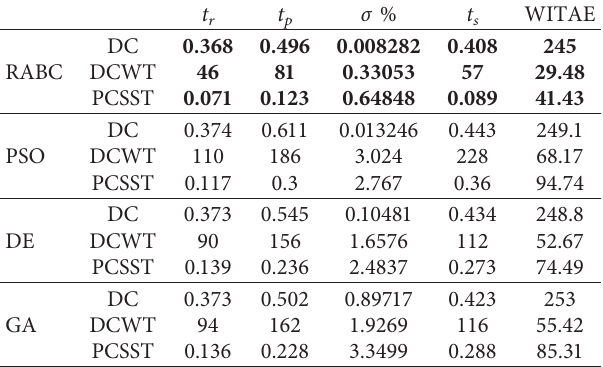
Table 8: Performance index when the parameters T � 20, T � and a 3